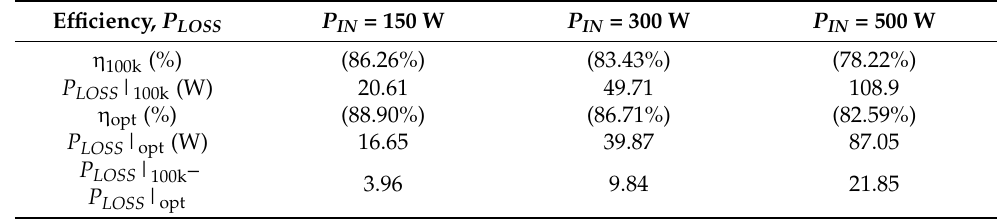
Table 5. Improvement in terms of power losses for optimal operating mode of the